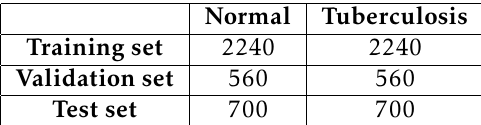
Table 1. Details about how Tuberculosis (TB) Chest x-ray database is splitted